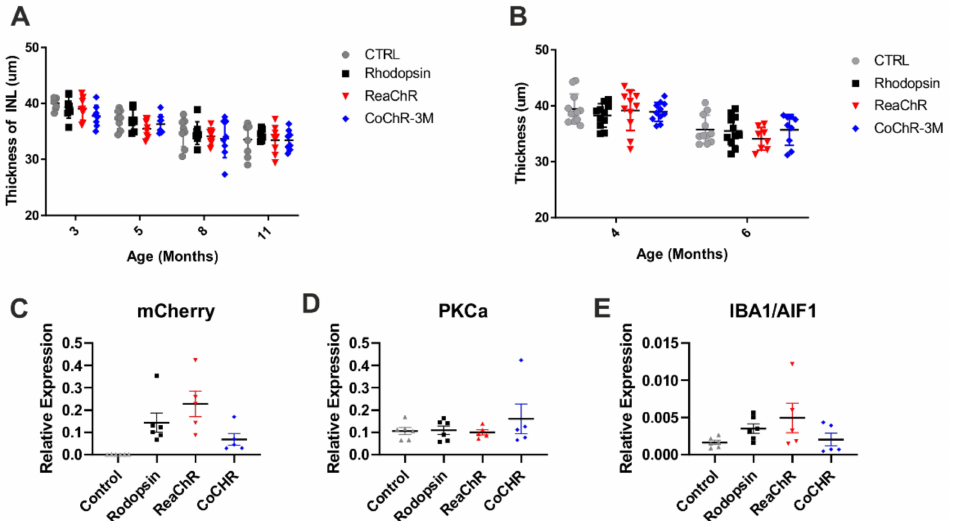
Figure 5. Toxicity study of opsin-treated Grm6 Cre rd1/rd1 retinae. ( A ) Longitudinal study and ( B ) non-longitudinal study of INL thickness in rod opsin; ReaChR- and CoChR-3M-treated and control mice. ( C ) mCherry relative expression in rod opsin; ReaChR- and CoChR-3M-treated and non-injected control mice. ( D ) PKC α relative expression and ( E ) IBA1/AIF1 relative expression in rod opsin; ReaChR- and CoChR-3M-treated and control mice. There was a significant decrease in the INL thickness observed over time in all mice (two-way RM-ANOVA main effect of time p < 0.001), but no impact of any of the treatments was found ( p > 0.05). Analysis of the expression of PKCa and IBA1/AIF1 found no difference between any of the treatments compared to controls (the Kruskal–Wallis test with Dunn’s multiple comparisons correction, p >